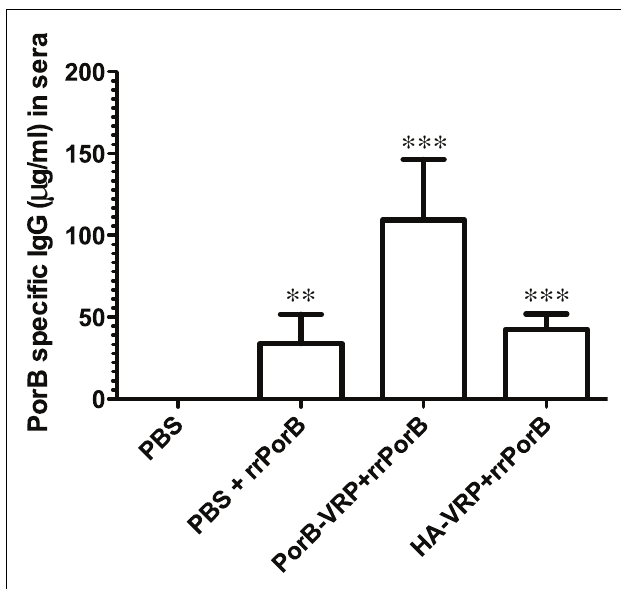
FIGURE 4 | PorB specific IgG levels in sera after different vaccination regimens. BALB/c mice were immunized with HA-VRP, PorB-VRP, or PBS for two times at 2weeks intervals and then boosted with rrPorB as the last immunization. Another control group was immunized three times with PBS at 2weeks intervals. Four weeks after the last immunization, sera were collected and IgG responses against a pool of synthetic PorB peptides were measured by quantitative ELISA. Each column represents mean ± SD. Data were analyzed by one-way ANOVA followed by unpaired Student’s t -test. Symbols: ** p < 0.01; *** p < 0.001 as compared to PBS control. PBS + rrPorB is different from PorB-VRP + rrPorB ( p = 0.002); PorB-VRP + rrPorB is different from HA-VRP + rrPorB ( p = 0.003); but PBS + rrPorB is not different from HA-VRP + rrPorB ( p =